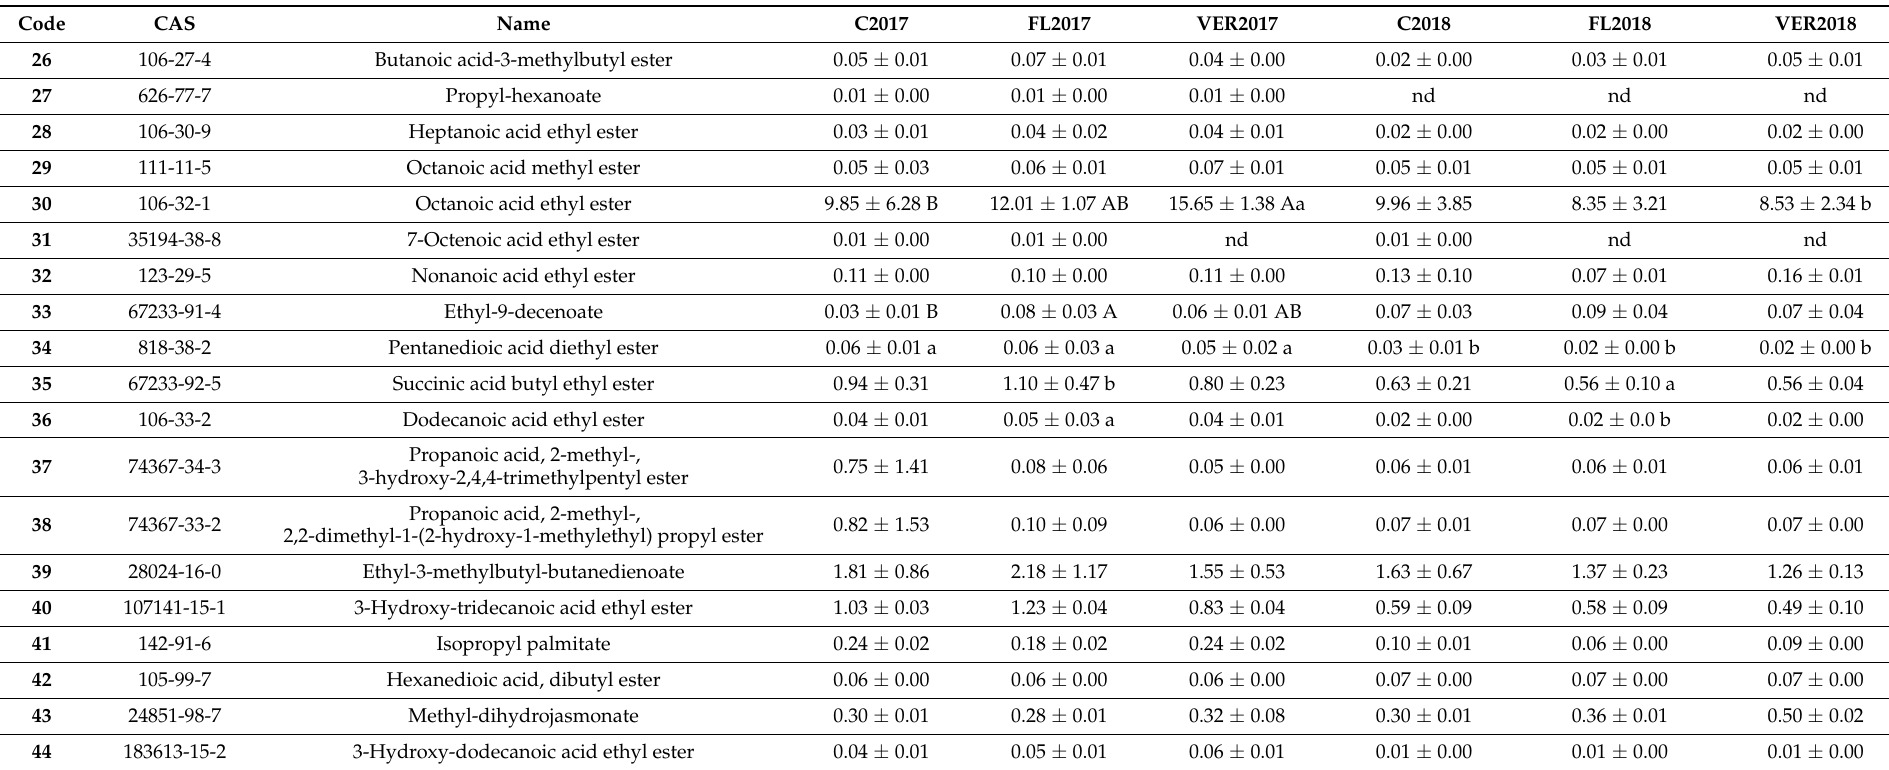
Table 3. Effects of defoliation treatments and vintage on concentrations of aliphatic esters (C9 and higher) ( µ g/L). (The quantification was conducted by using a linear standard calibration with decanoic acid ethyl ester.) C = control; FL = removal of six leaves before flowering; VER = removal of six leaves at the end of